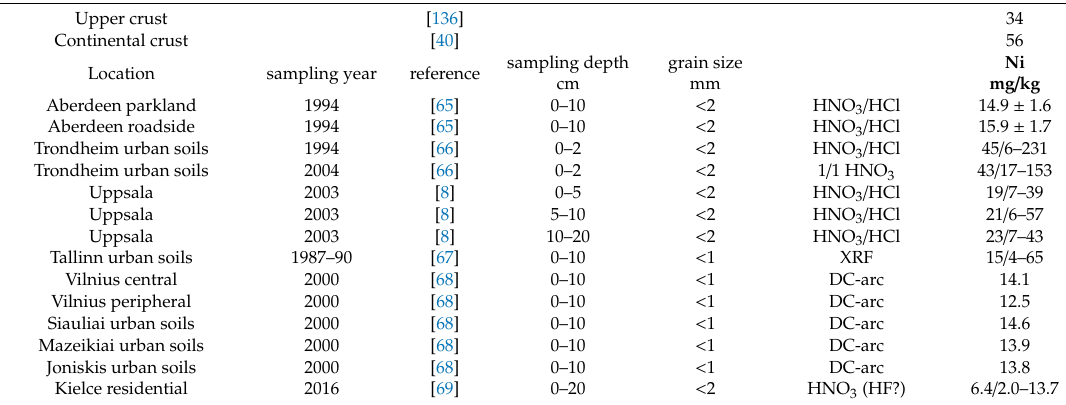
Table A15. Nickel in urban